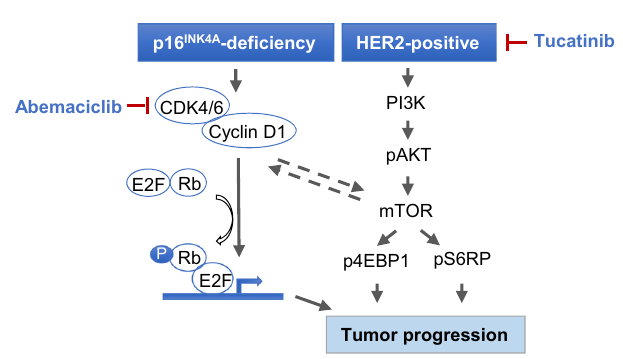
Fig. 4 Schematic diagram of rational combination of tucatinib and abemaciclib for HER2 + , p16 INK4A -de fi cient